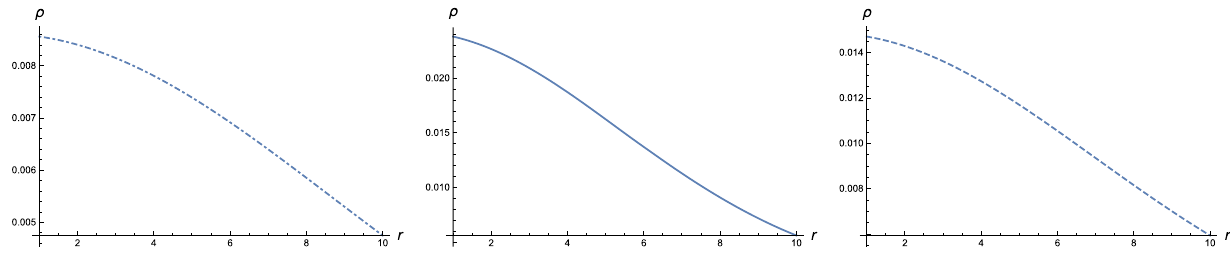
Fig. 1 Plot of the density evolution of the strange star candidate Her X-1, SAX J 1808.4-3658, and 4U 1820-30; represented by (left to right) the first, second, and third graphs, respectively